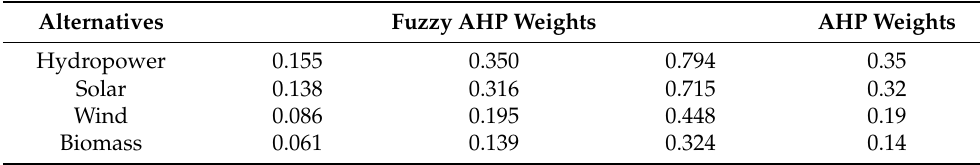
Table 4. Comparison between alternative weights of AHP and fuzzy